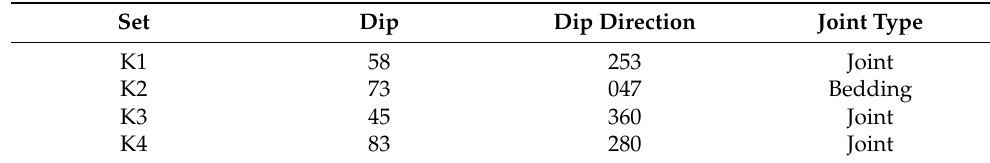
Table 1. The four joint sets recognized in the rock mass of the study area.